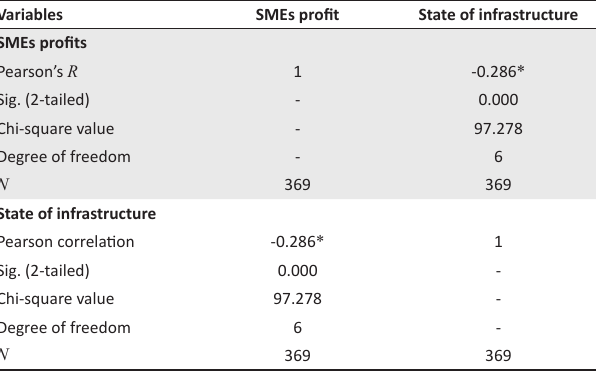
TABLE 4: Comparison of the state of infrastructure and the operational cost of